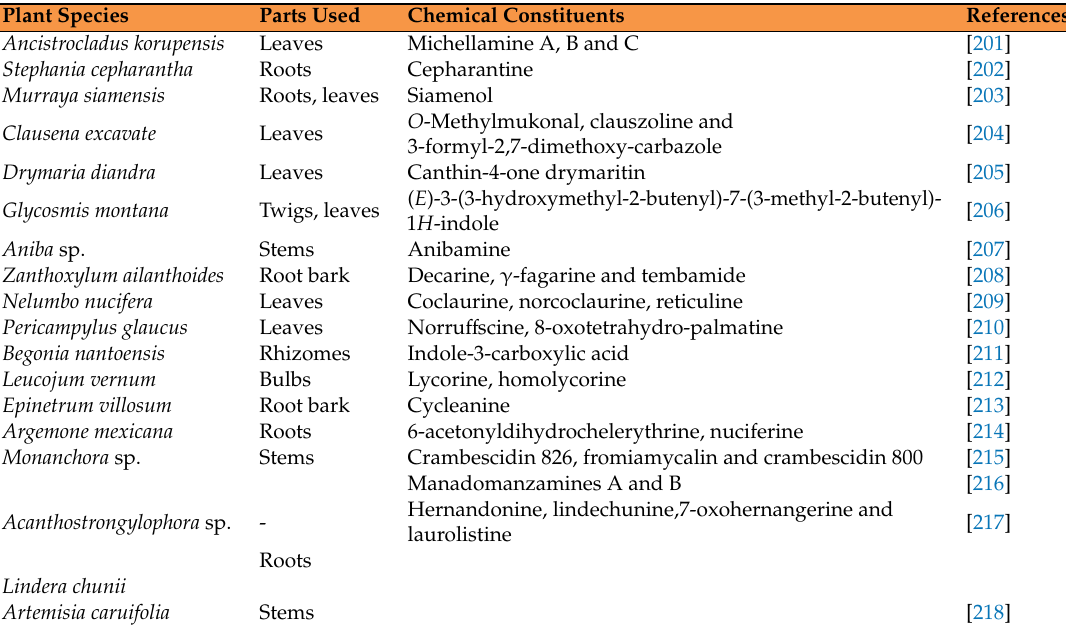
Figure 9. Plant-based antioxidants compounds possessing anti-HIV potential. Table 2. Alkaloidal compounds as anti-HIV